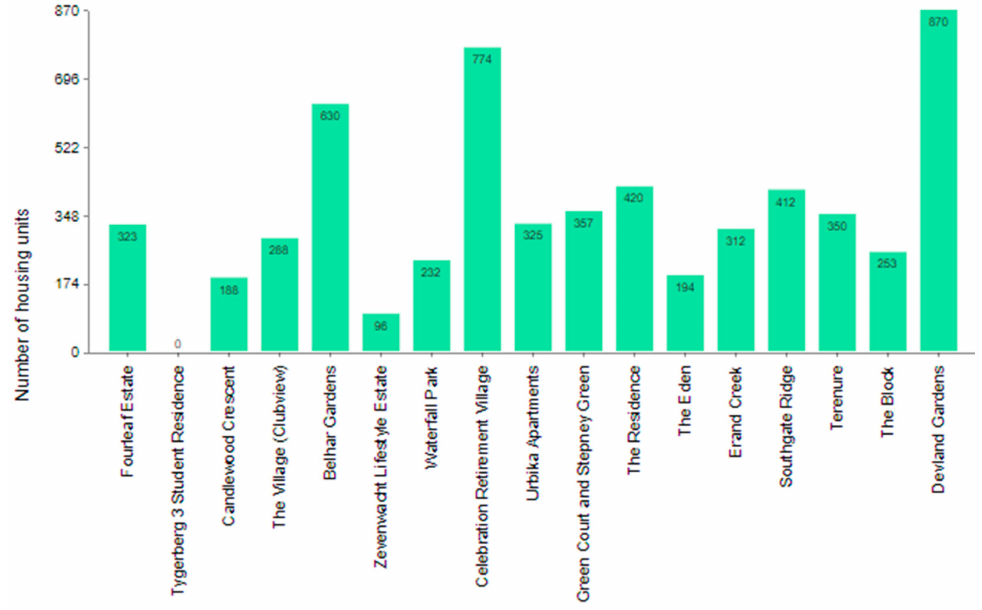
Figure 9. Number of housing units of the 17 South African residential complexes with EDGE